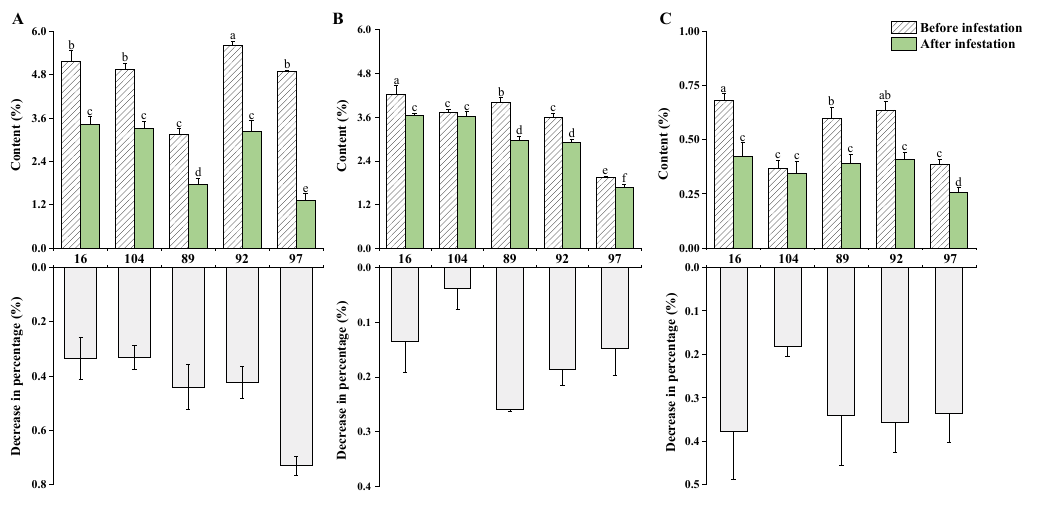
Figure 7. The content and change of ( A ) soluble sugar; ( B ) sucrose; and ( C ) fructose before and after aphid infestation treatment. Each value was the mean (±SE) of three replicates. Tukey’s multiple range tests at p < 0.05 were used to compare means by SPSS. The letters (a−f) in the figures indicate a significant difference among experimental sugarcanes.